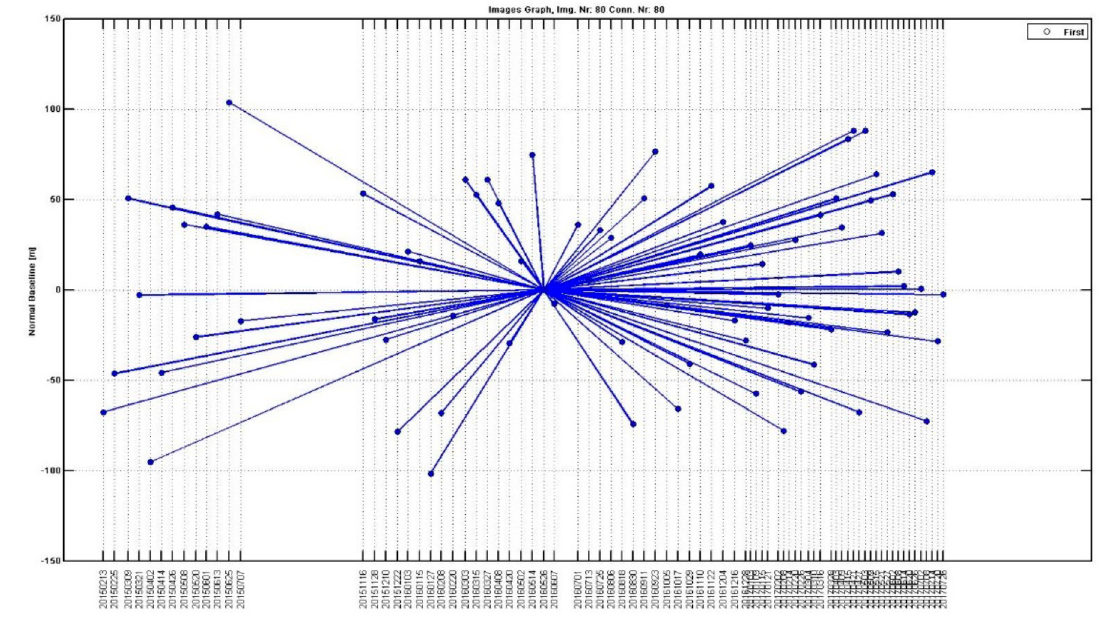
Figure 5. Star graph drawing showing the temporal / perpendicular baseline distribution of data pair of the orbit number 161. Blue lines represent the interferogram of two SAR acquisitions in blue dotes. For the second stack of 80 images, acquired from an ascending orbit (number 161) during the period 13 February, 2015 to 27 July, 2017, the image from 26 May, 2016, was chosen as the master image (see Figure